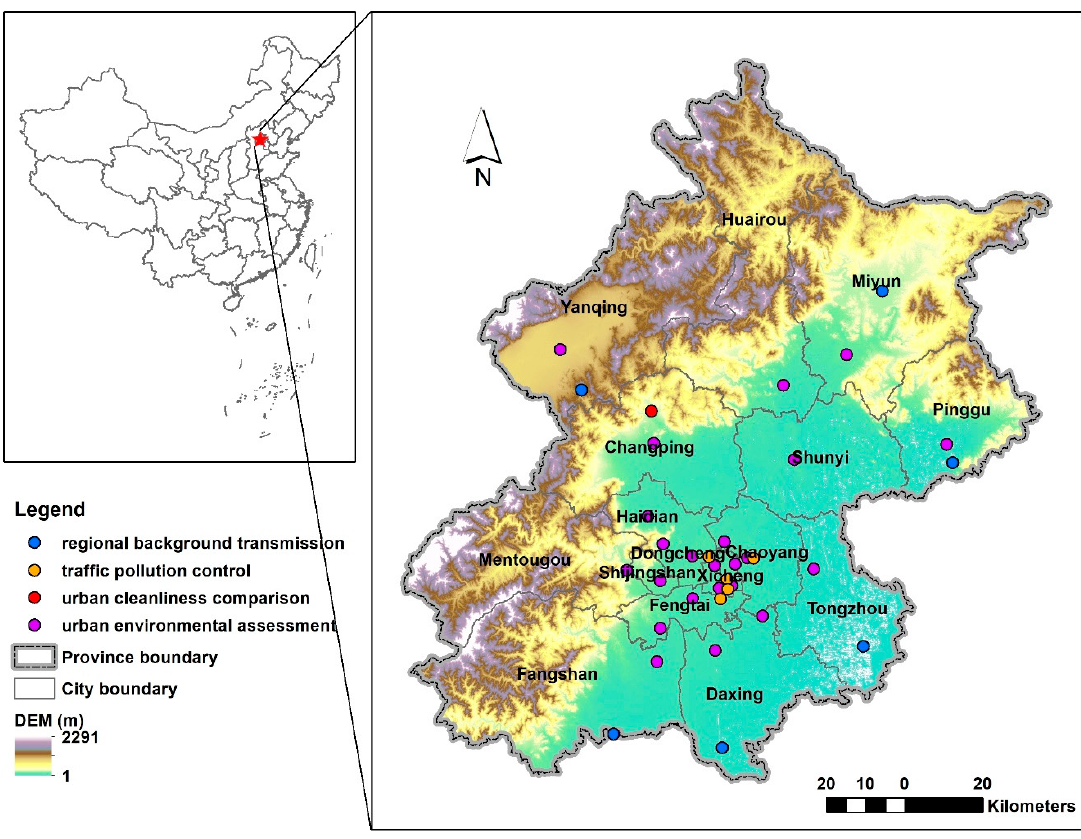
Figure 1. Location of Beijing and its PM 2.5 monitoring sites.